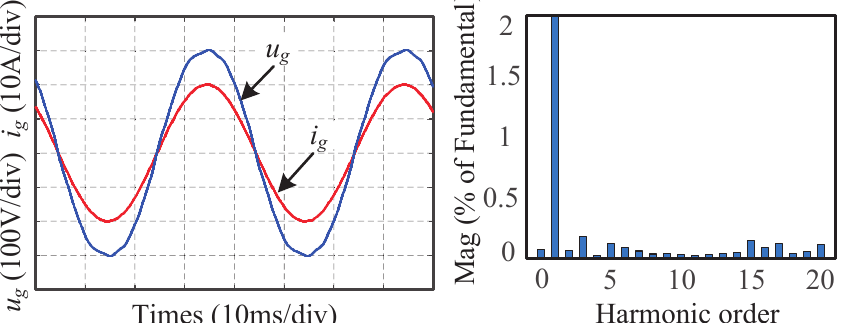
Figure 19. Output waveforms of the FA-IRC system and spectrum analysis of the output current when f g = 50.4